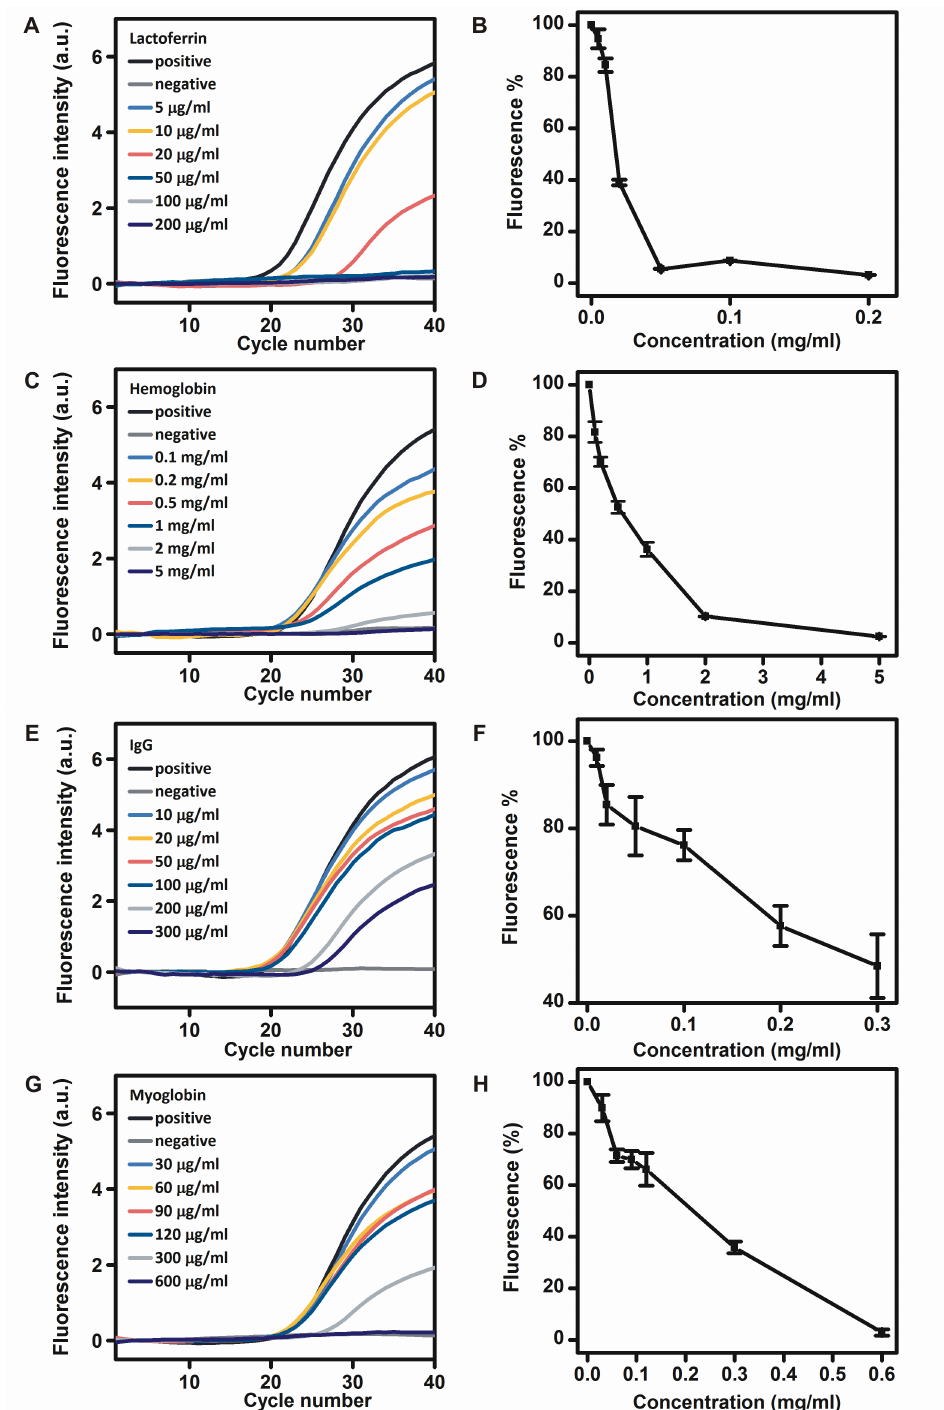
Fig 4. Inhibitory effects of different concentrations of lactoferrin A, B), hemoglobin C, D), IgG E, F), and myoglobin G, H) on the RNA detection by r Tth polymerase.